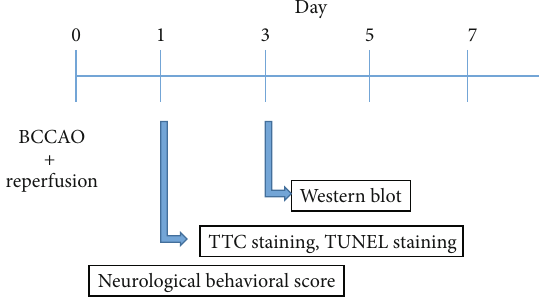
Figure 1: Basic depiction of the experimental design. Global cerebral ischemia/reperfusion treatment at the age of about eight- week-old male mice. In this study, three experimental groups were analyzed: sham group, WT & I/R group, and p38 KI/+ & I/R group. TTC staining, western blot analysis, TUNEL staining, and neurological score were performed and